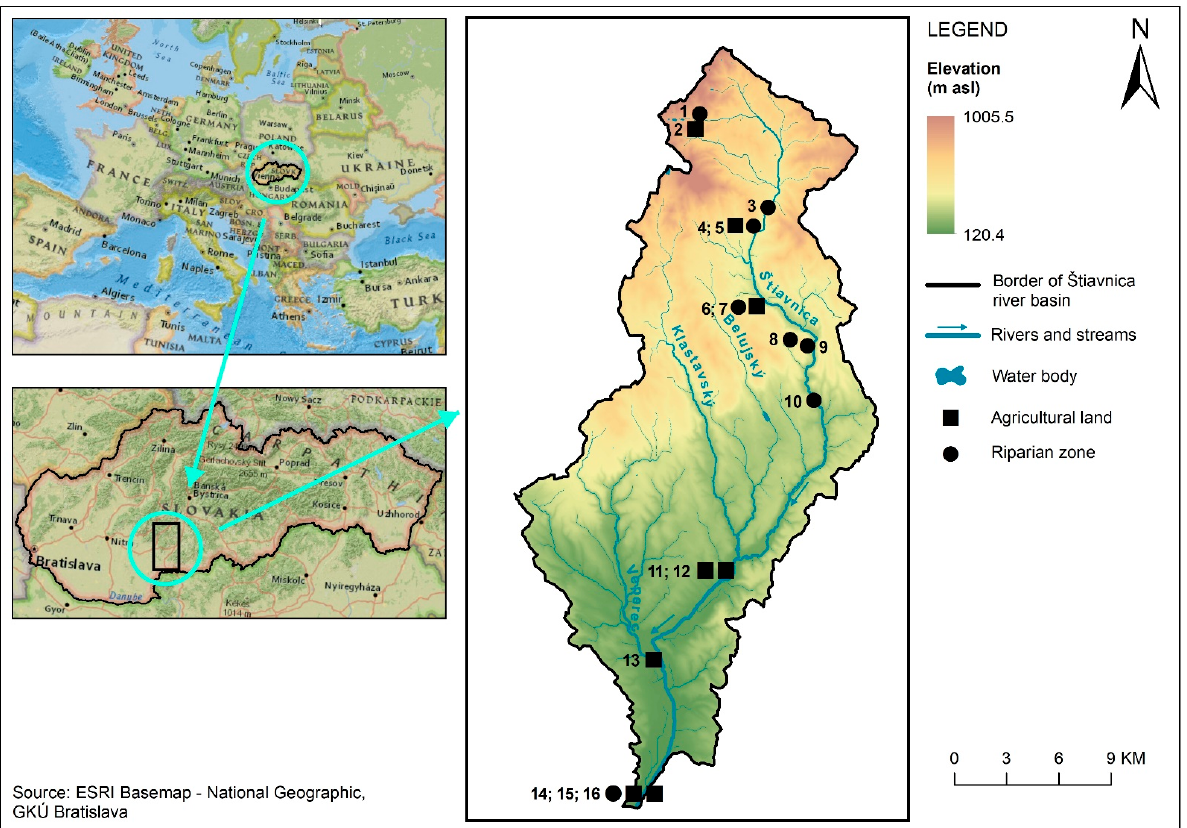
Figure 1. Map of the 16 localities in the floodplain of the Štiavnica River.